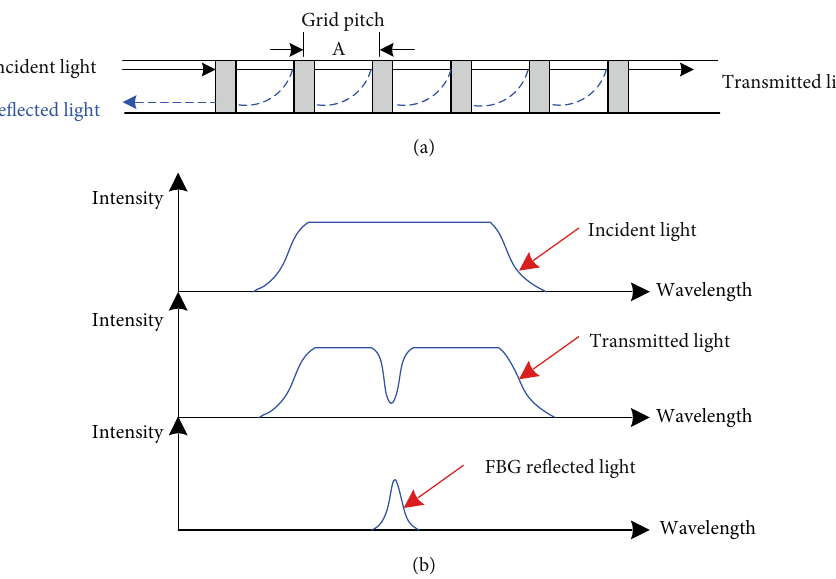
Figure 3: Grating re fl ection diagram [42]: (a) fi ber Bragg grating; (b) re fl ected light